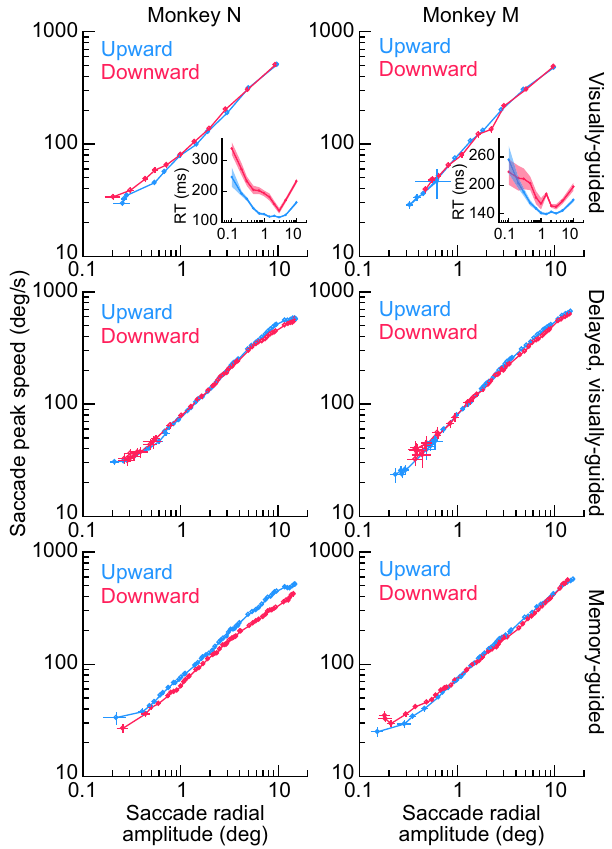
Fig. 4 The main sequence relationship between peak eye speed and saccade amplitude does not depend on whether saccades are upward or downward for a variety of behavioral task contexts. In each monkey (left and right columns), we plotted the main sequence from database 2 but after fi rst separating saccades as being directed towards either the upper visual fi eld (light blue) or lower visual fi eld (light red). The fi rst two rows show visually-guided saccades (immediate for the fi rst row, and delayed based on a task instruction in the second row; “ Methods ” ). The third row shows memory-guided saccades towards a blank region of the display. The insets in the fi rst row show saccadic reaction time (RT) data (as in Fig. 3b, left) for the same saccades as in the main sequence plots, to highlight the strong presence of a visual fi eld effect on reaction times and a concomitant absence of a visual fi eld effect on saccade kinematics. In all saccade contexts (across rows), the visual fi eld location of the saccade endpoint had minimal effect on saccade kinematics (despite a large effect on saccadic reaction times and despite an asymmetry in SC motor bursts; Fig. 1). The insets in the fi rst row directly replicate the plots in Fig. 4a, c of ref. 36 for easier comparison of effect sizes for reaction times and kinematics. Error bars denote s.e.m. Note that monkey N showed a small reduction of peak eye speed for downward saccades when compared to upward saccades only in the memory-guided condition (bottom row), but this effect is opposite from what would be expected if SC motor bursts (Fig. 1) dictated kinematics. The insets were replotted with permission from ref. 36